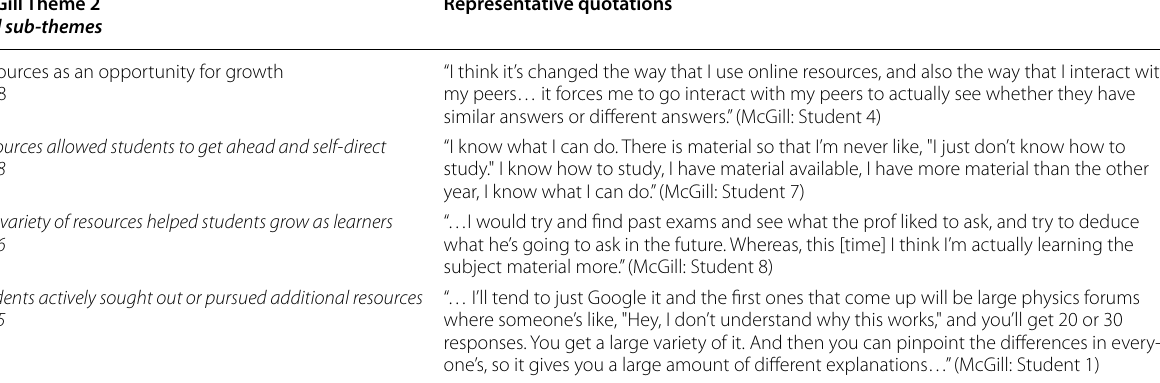
Table 4 McGill institutional analysis—Theme 2